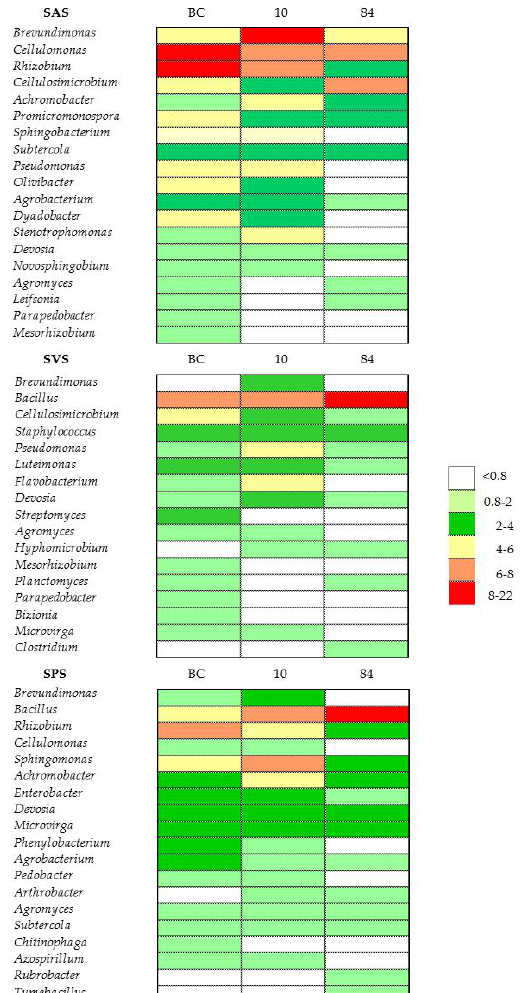
Figure 5. Heatmap showing the relative abundance of OTUs at the genus level in the biopurification systems composed of SAS, SVS and SPS biomixtures, before contamination (BC) and at 10 and 84 d after the addition of the PPCPs. Only OTUs with a relative abundance >1% in at least one sample are shown. The color code indicates the range of relative abundance for a given genus.